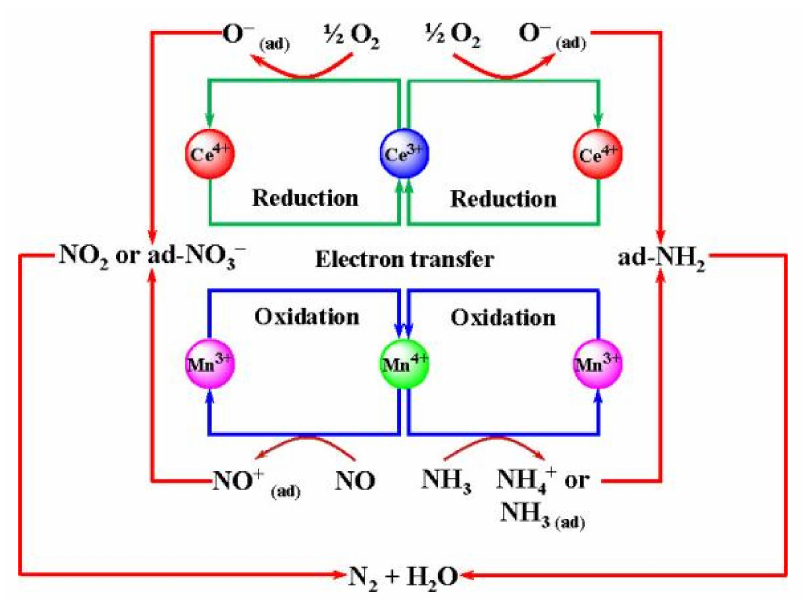
Figure 1. Mechanism for the SCR process of MnO x /CeO 2 . Reproduced with permission from Reference [45]; copyright (2017),